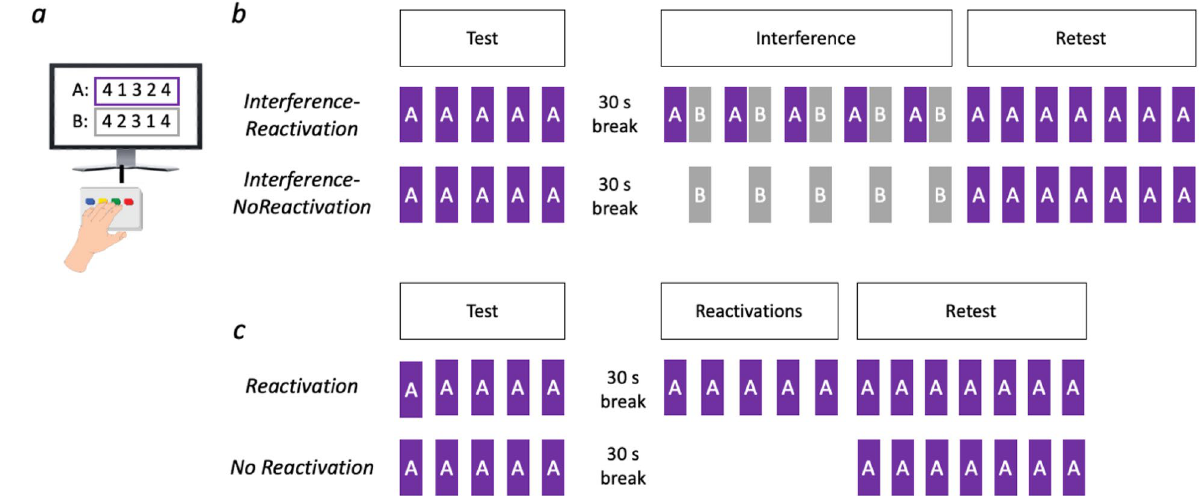
Figure 1. Experimental design. ( a ) The sequence tapping task required participants to tap a sequence of numbers (either sequence A: 4 1 3 2 4 or sequence B: 4 2 3 1 4) which was constantly presented on the screen during trials. ( b ) Experimental design of Experiment 1. Each purple square represents a trial of the main sequence A, and each grey square represents a trial of the new sequence B. ( c ) Experimental design of Experiment